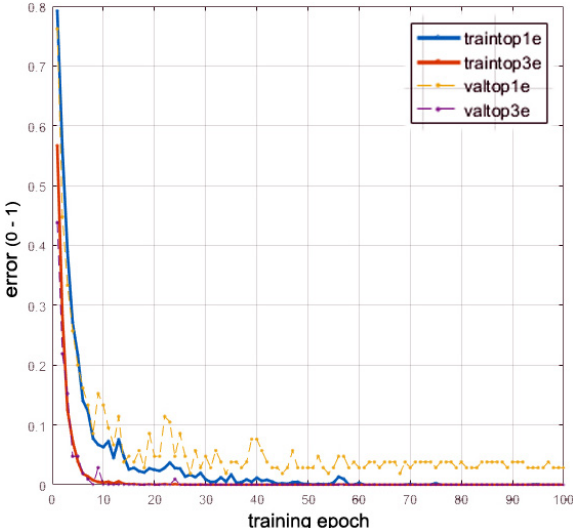
Fig. 7. The curves of validation error of experiments of the Swedish data set with augmentation three channels VGB. Depending on the random initialization value of weight, the error level is gradually reduced, after each training